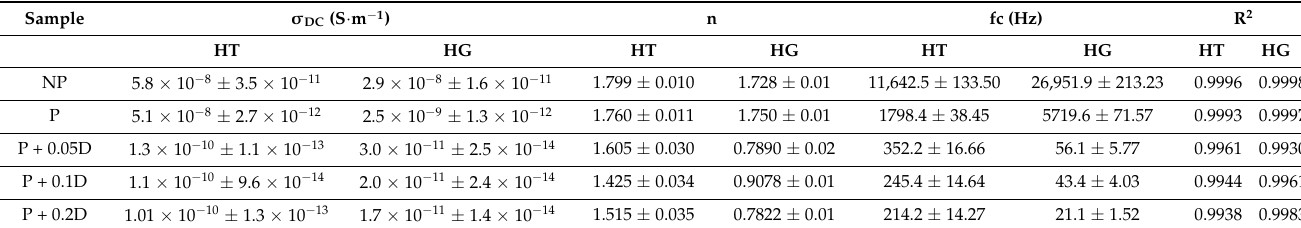
Table 1. Fitting parameters obtained from experimental data of σ ’using Jonscher’s